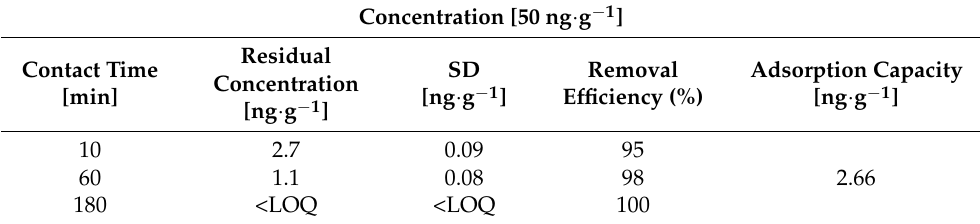
Table 6. Adsorption of barium from a 50 ng · g − 1 stock solution onto PCT. The initial concentration was 51.5 ± 0.3 ng · g − 1 .